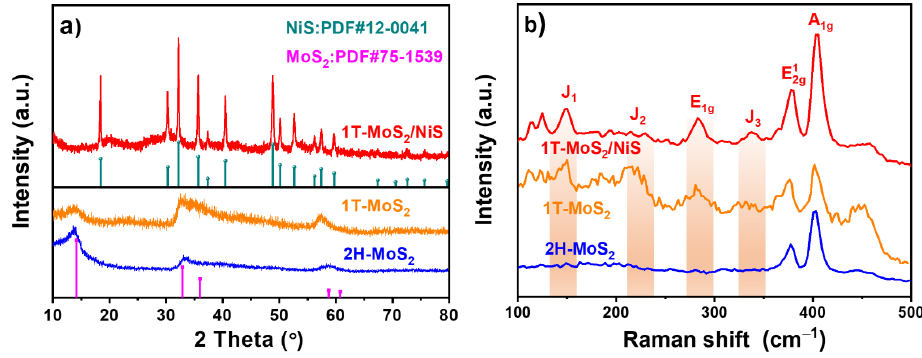
Figure 2. ( a ) XRD spectra and ( b ) Raman spectra of the 2H-MoS 2 , 1T-MoS 2 and 1T-MoS 2 /NiS.